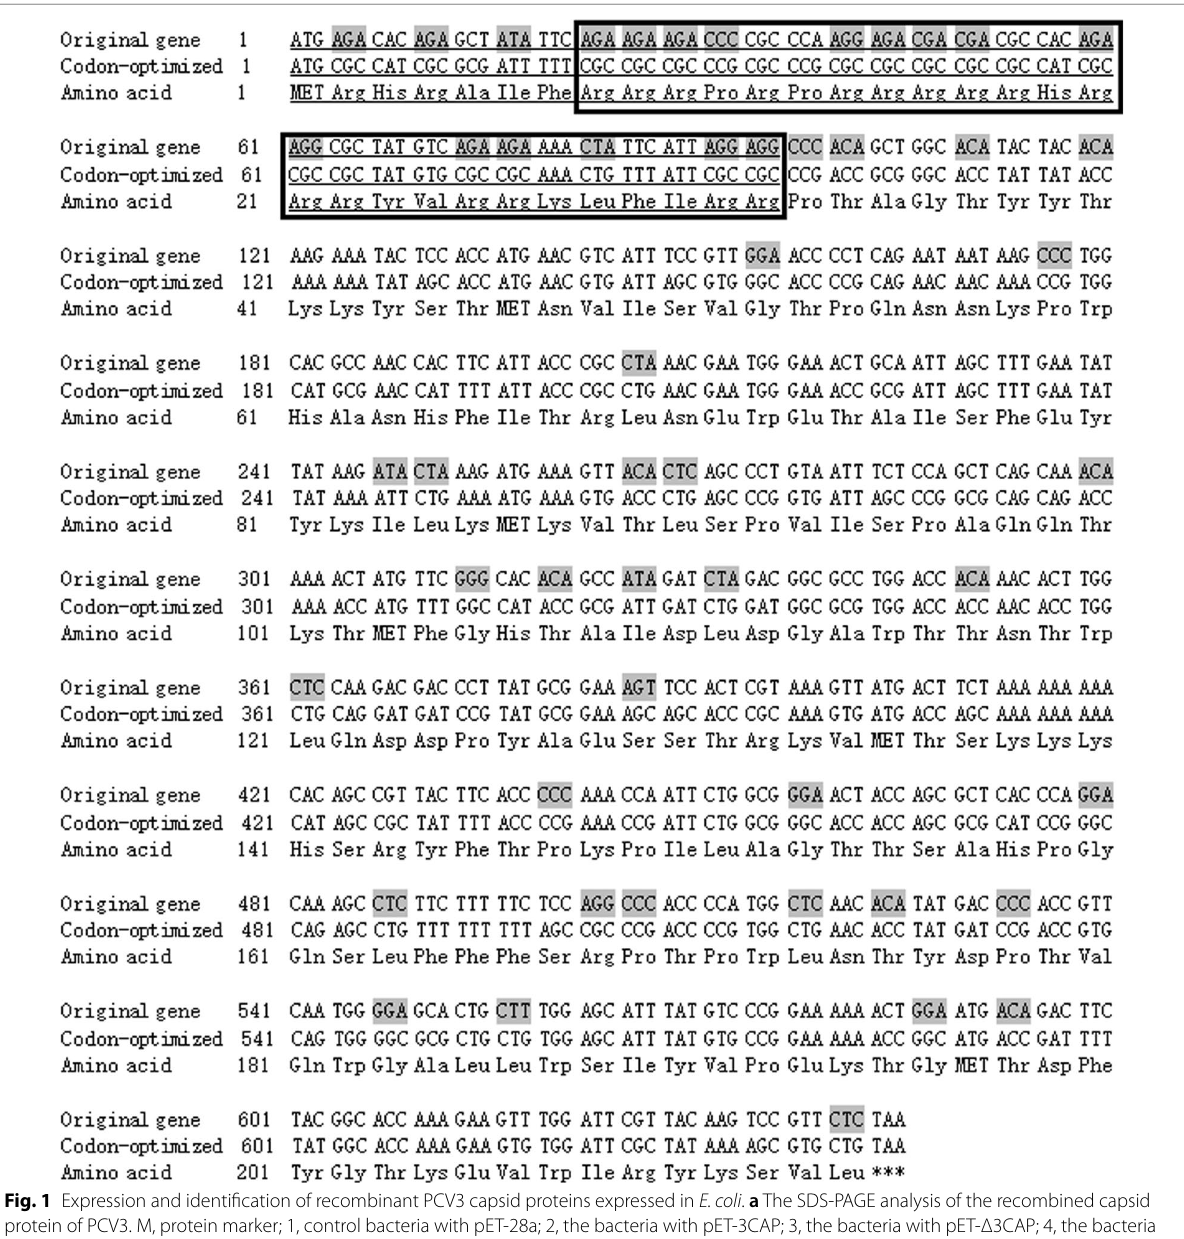
Fig. 1 Expression and identification of recombinant PCV3 capsid proteins expressed in E. coli . a The SDS-PAGE analysis of the recombined capsid protein of PCV3. M, protein marker; 1, control bacteria with pET-28a; 2, the bacteria with pET-3CAP; 3, the bacteria with pET-Δ3CAP; 4, the bacteria with pET-3CAP-O; 5, the bacteria with pET-Δ3CAP-O. b Western blots analysis of the expressed recombined proteins using the anti-His antibody. The blot corresponds to lanes 1–5 from ( a ). The arrows represent the location of the recombined ΔCAP (25 kDa), respectively. The expression of the recombined CAP protein did not be